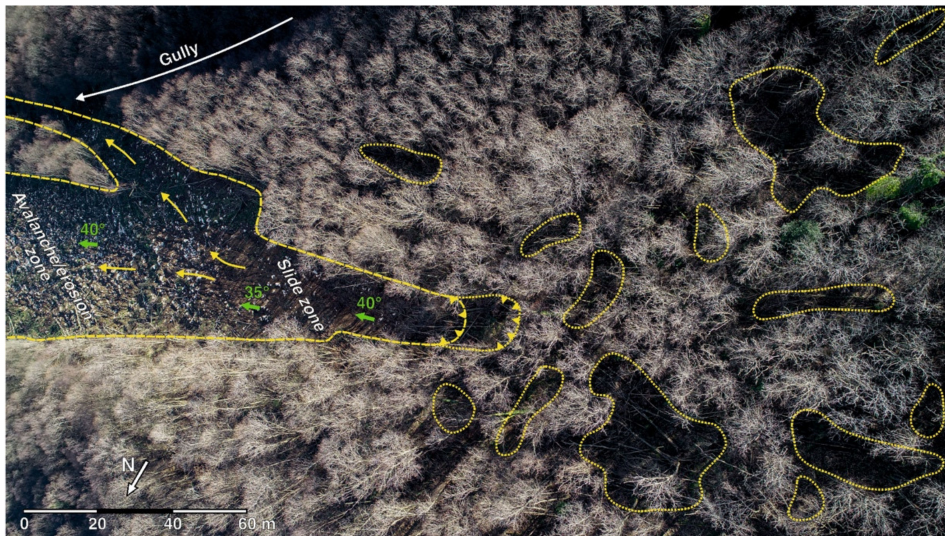
Figure 10. Upper landslide area of the December 2019 debris flow, showing the direction of the flow (yellow arrows), the slope angle, and dip direction (green numbers and arrows). Several further instabilities occurred that failed to trigger debris avalanches (areas bounded by yellow dotted lines).